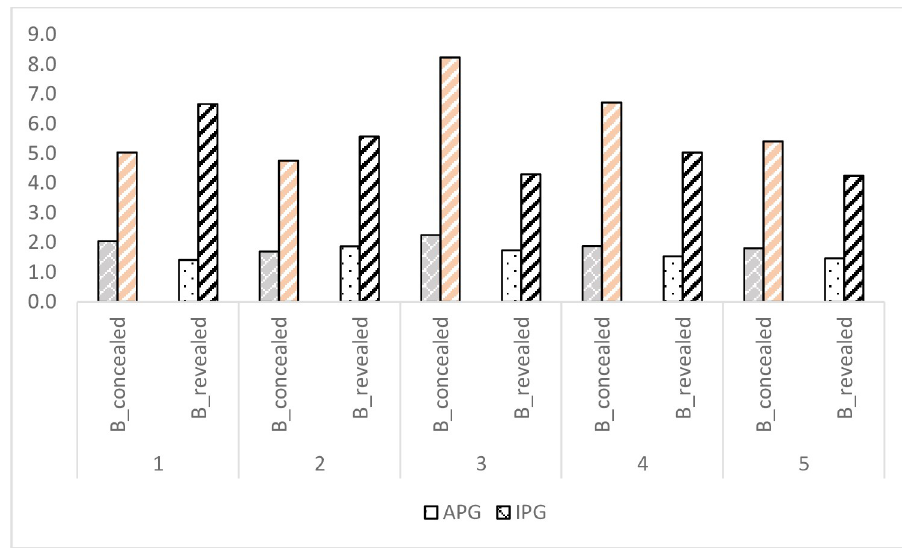
Fig 3. Intended price gain (IPG) and average price gain (APG) in contract